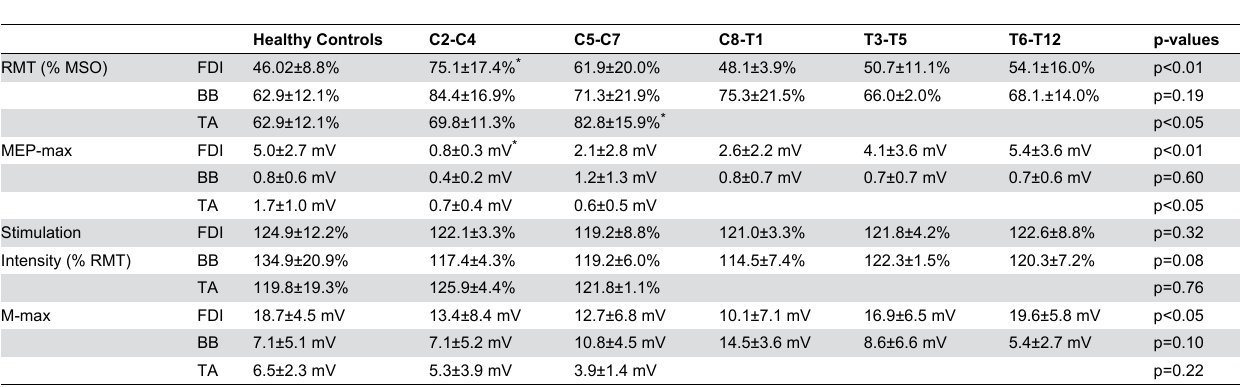
Table 3. Stimulation parameters, MEP-max and M-max